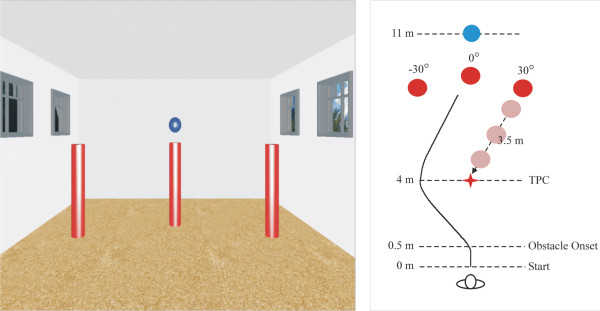
Schematic representation of the virtual scene. The left panel shows the screenshot of the virtual scene with the 3 red cylindrical obstacles and the blue target. The right panel illustrates the dimensions of the testing area and the relative positions of the participant and the obstacles. The red star symbol represents the theoretical point of collision (TPC).